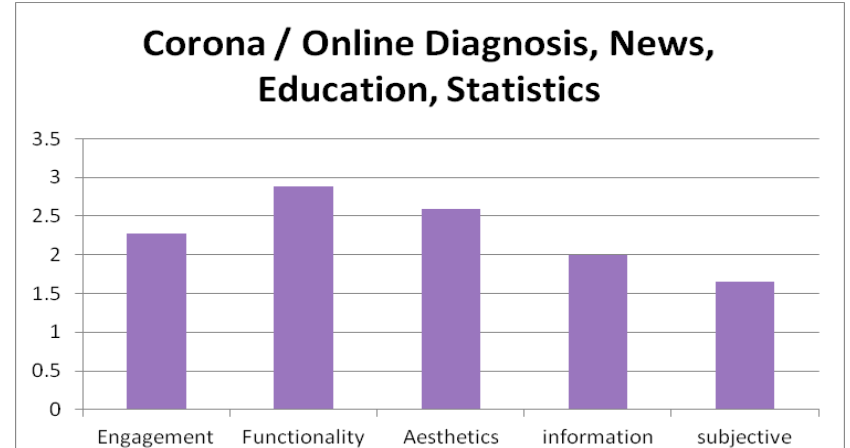
Fig 9. The evaluation of indicators in Corona / Online Diagnosis, News, Education, Statistics according to MARS subscales